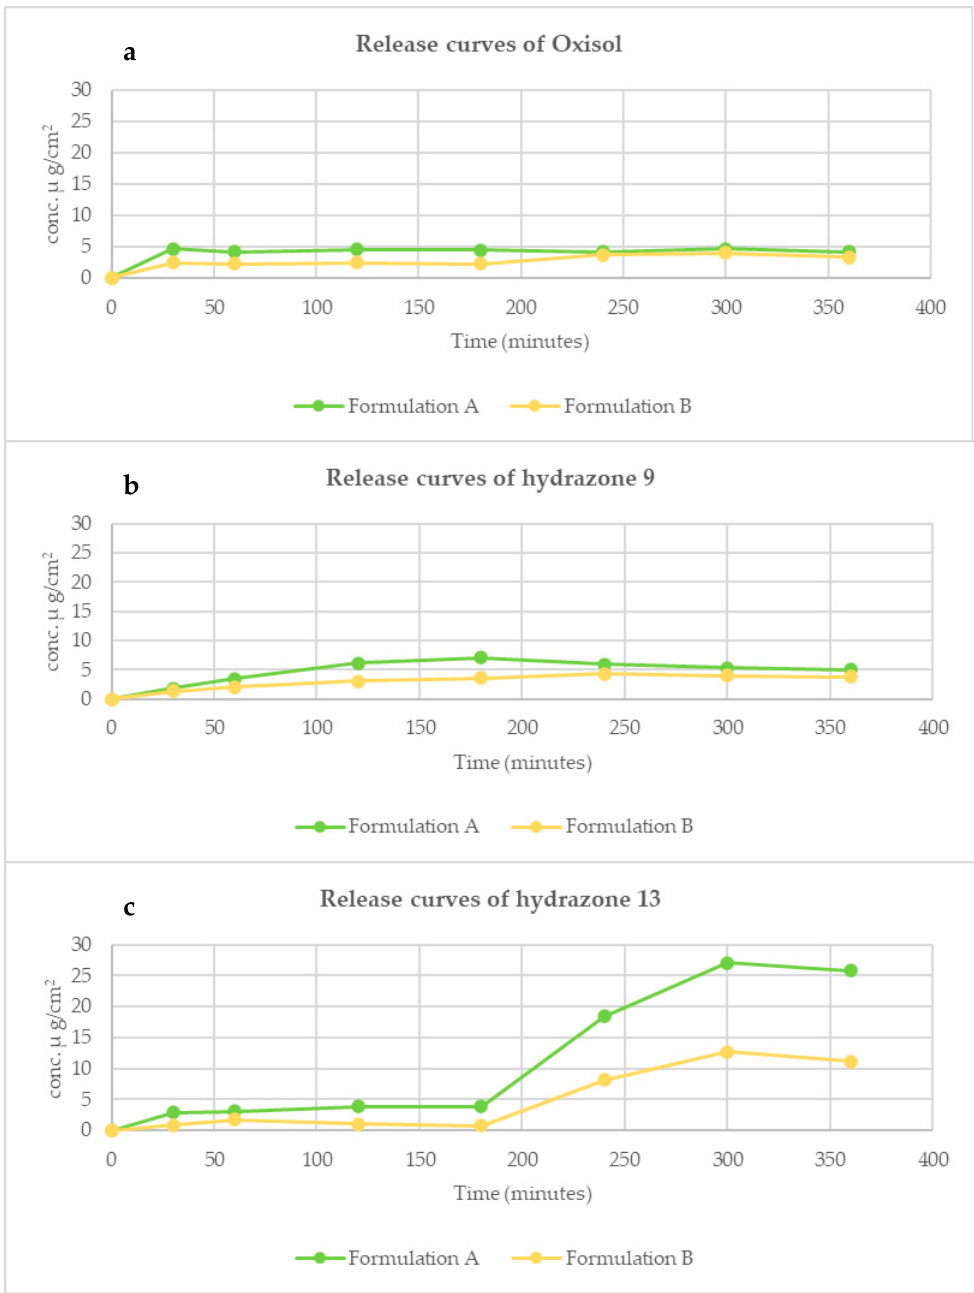
Figure 2. Permeation profiles of Oxisol (panel ( a )), and hydrazones 9 (panel ( b )) and 13 (panel ( c )). Line green corresponds to formulation A (optimized for skin adsorption), line yellow corresponds to Formulation B (optimized to best solubilize the active in formula).